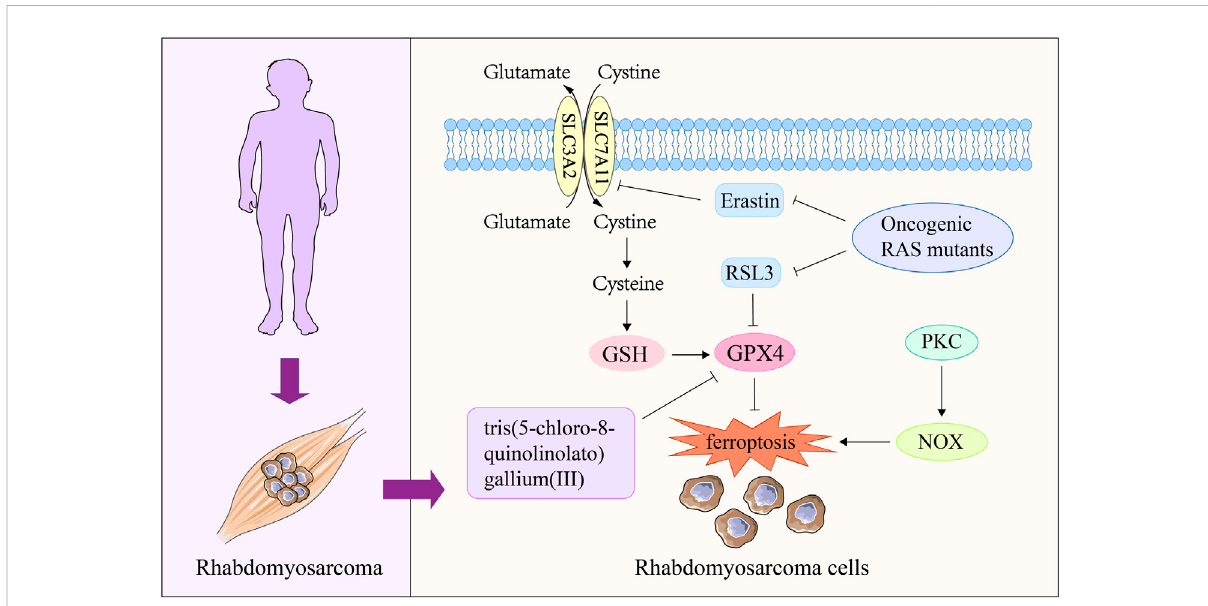
FIGURE 4 Therole offerroptosisinrhabdomyosarcoma.OncogenicRASmutants arethekeymediatorofRMSdisease, which canblocktheferroptosisof RMS cells induced by erastin and RSL3. The complex tris(5-chloro-8-quinolinolato) gallium (III) can induce ferroptosis in RMS cells by reducing GPX4expression,therebyexertingtherapeuticeffectson RMS.TheactivationofPKC-NOX pathway